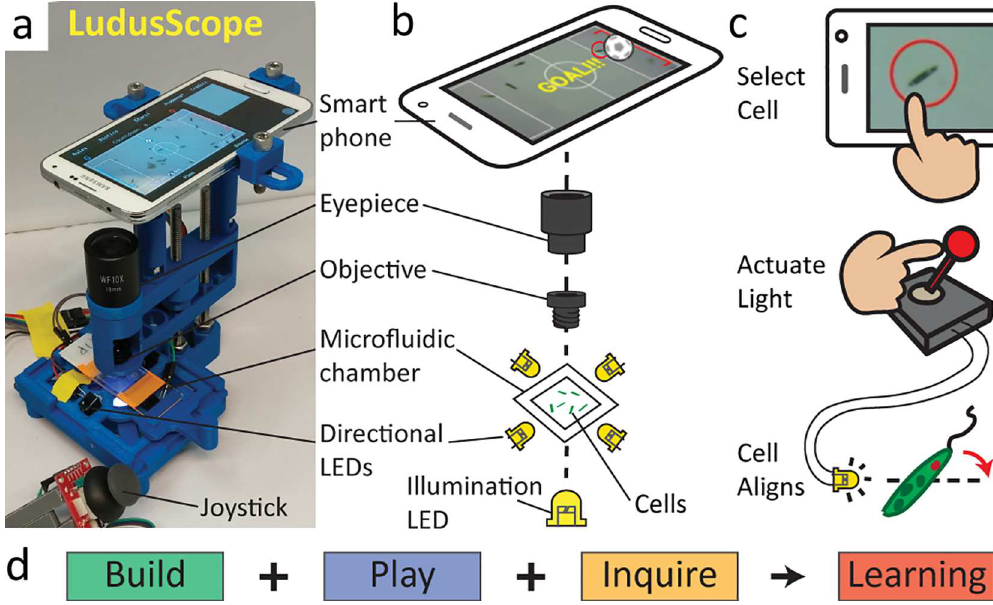
Fig 1. The LudusScope turnsobservational microscopy intoan interactiveexperience by enabling open- endedinteractionwithmicroorganisms. ( A ) The LudusScopewith smartphone attacheddisplaying an interactive biologyapplication.( B ) The optics of the LudusScopemimicsa traditional microscope, but four additionalLEDs allow stimulationof motilemicroorganisms, e.g., Euglenagracilis .( C ) The user can interactwith individualcells by digitallyselectingthemvia touch screen,and then operatea joystick to actuatethe four directionalLEDs, which then provide light stimuli to induce phototacticresponses,e.g., the cell’s swimming directionaligns with the light.( D ) The LudusScope integrates threeessentialeducational modalities: Build, play, and